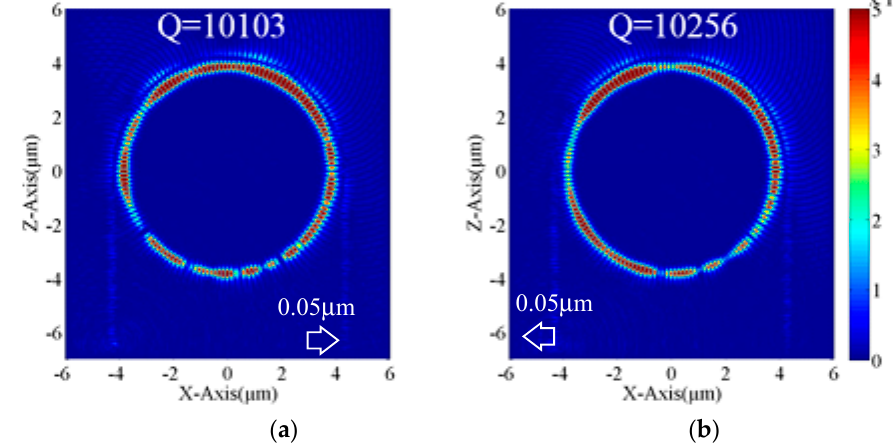
Figure 2. Optical field distributions of the PTRR with waveguide offset. ( a ) The output waveguide is shifted to the right by 0.05 μ m; ( b ) The input waveguide is shifted to the left by 0.05 μ m.